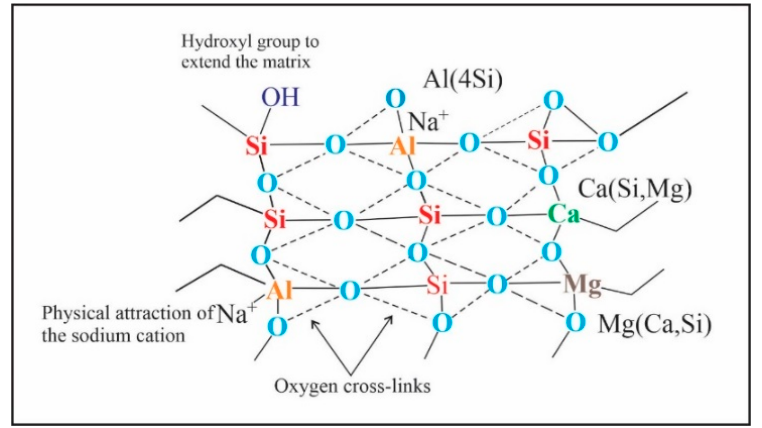
Figure 11. Schematic model of geopolymer bonding [45], with permission from Elsevier, 2021.